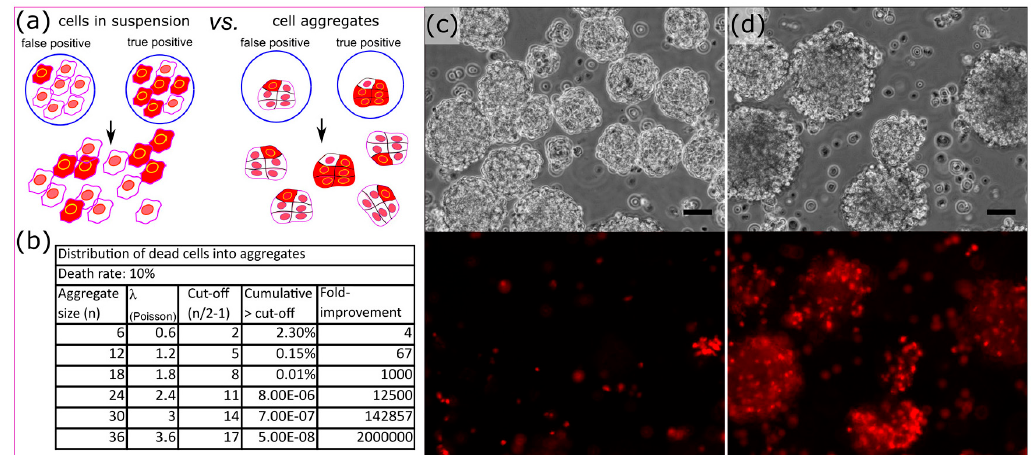
Figure 7. Aggregate strategy to reduce the effect of background apoptosis on the identification of bio-active compounds. ( a ) Screening the effect of rare bio-active compounds on cell aggregates reduces the noise due to background apoptosis (red: apoptotic cells); ( b ) Effect of the aggregate size on the enrichment of true positives assuming a background apoptosis rate of 10% and a sorting threshold at the aggregate mid-size expressed in fold improvement compared to cells in suspension; ( c ) Manually generated heterogeneous aggregates non-treated and ( d ) treated with invasive violacein producing bacteria. The lower panels exhibit propidium iodide staining of those aggregates. The scale bars represent 50 μ m.